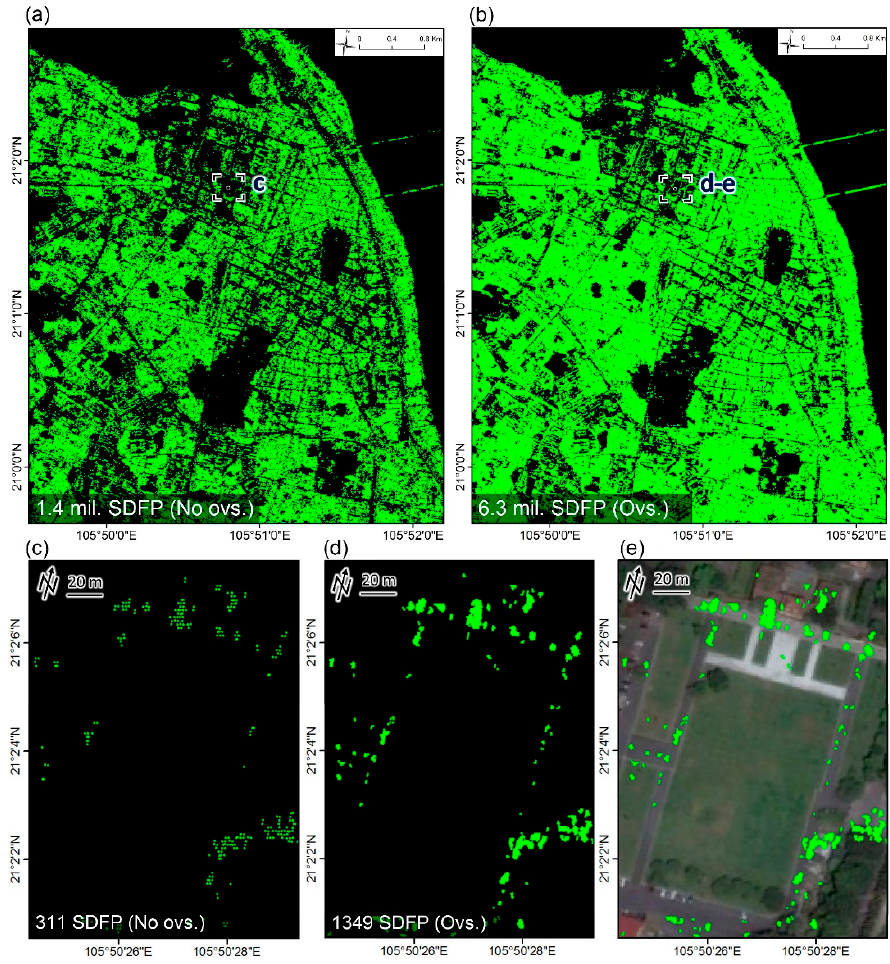
Figure 10. Binary images represent the spatial distribution of SDFP over study area derived by ( a ) normal TerraSAR-X data and ( b ) oversampled data. Enlarged SDFP location in Flag Pole Stadium for the data ( c ) without oversampling; ( d ) with oversampling and ( e ) with oversampling projected onto an optical image.